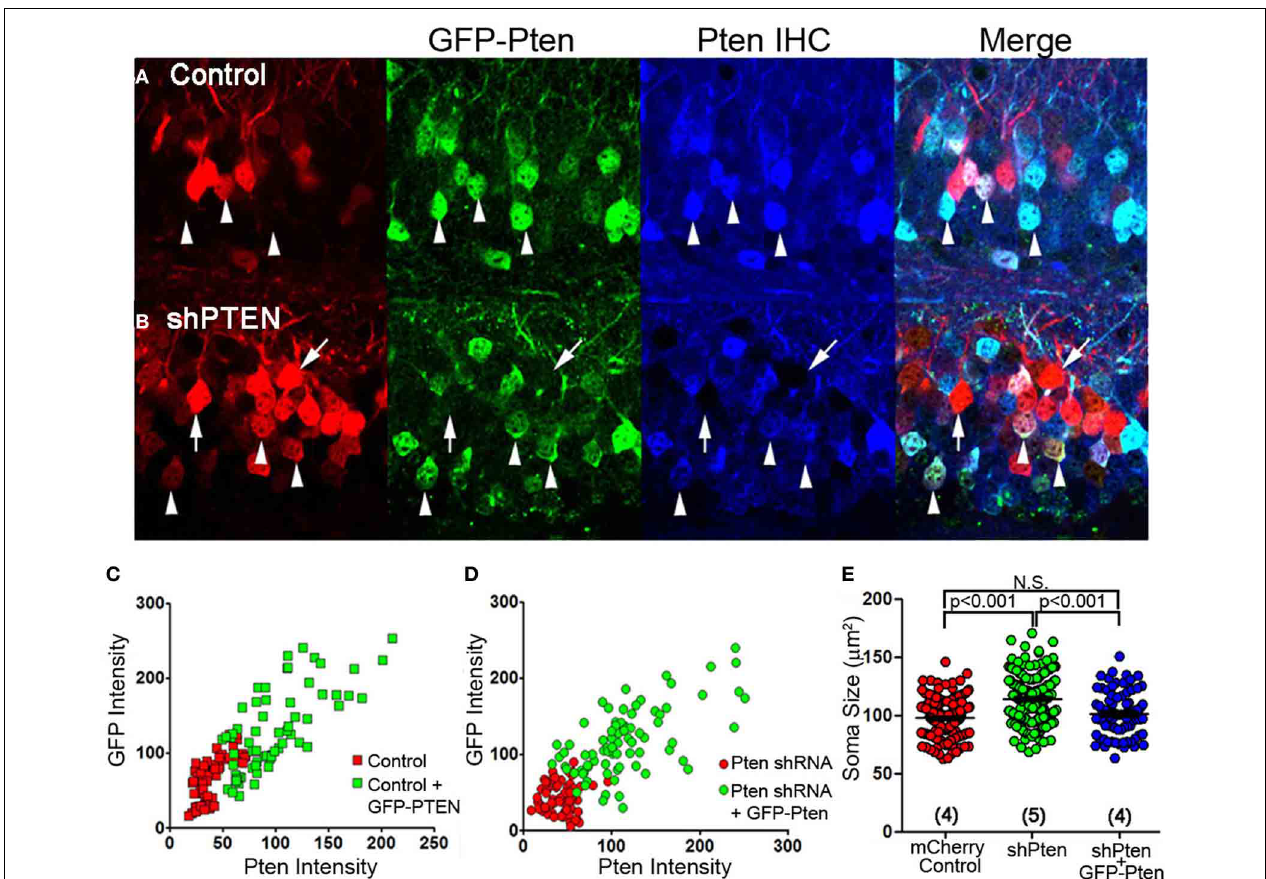
FIGURE 2 | Over-expression of wild-type Pten in Pten deficient neurons rescues hypertrophy caused by loss of function. An shRNA-insensitive GFP-Pten (GFP-PTEN) was generated by altering the wobble base pairs of the shRNA target sequence without changing the sequence of the encoded protein. (A) Neurons co-injected with an mCherry control virus and GFP-Pten were immuno-stained for Pten. (B) We then co-injected an mCherry labeled Pten shRNA and GFP-Pten lentivirus and immuno-stained these neurons for Pten. Neurons that were co-labeled (arrow heads) had an increase in Pten staining intensity compared to those expressing the shRNA only (arrows) (C) The GFP-Pten infected neurons (arrow heads) had ahigher intensityofPten staining than the wildtype neurons, and there was a positive correlation between Pten staining intensity and GFP intensity ( R 2 = 0 . 02, linear regression analysis). (D) There was a positive correlation between GFP signal